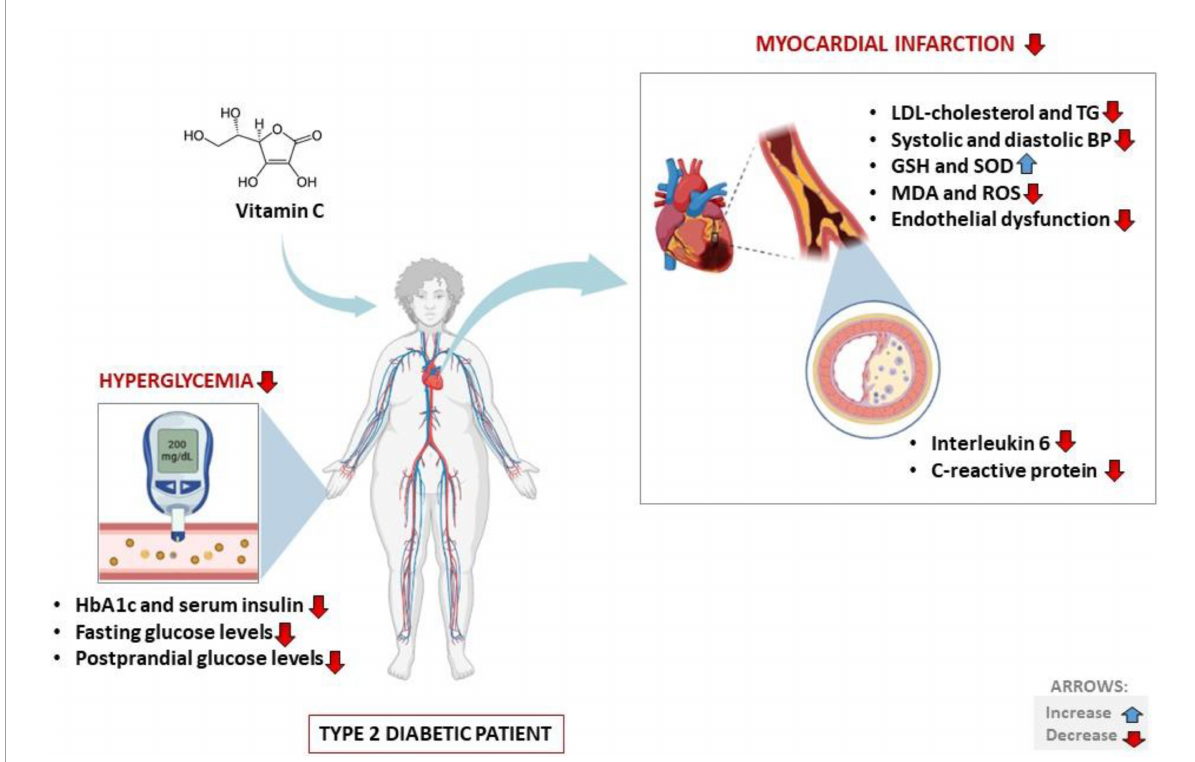
FIGURE3 Potential health benefits of vitamin C intake on cardiovascular disease-related outcomes in type 2 diabetic patients. Briefly, besides improving basic metabolic parameters such as impaired glucose/insulin levels, vitamin C intake ca also lower total cholesterol concentrations to reduce blood pressure and positively affect blood circulation. HbA1c, glycated hemoglobin; LDL, low-density lipoprotein; TG, triglycerides; GSH, glutathione; SOD, superoxide dismutase; MDA, malondialdehyde; ROS, reactive oxygen